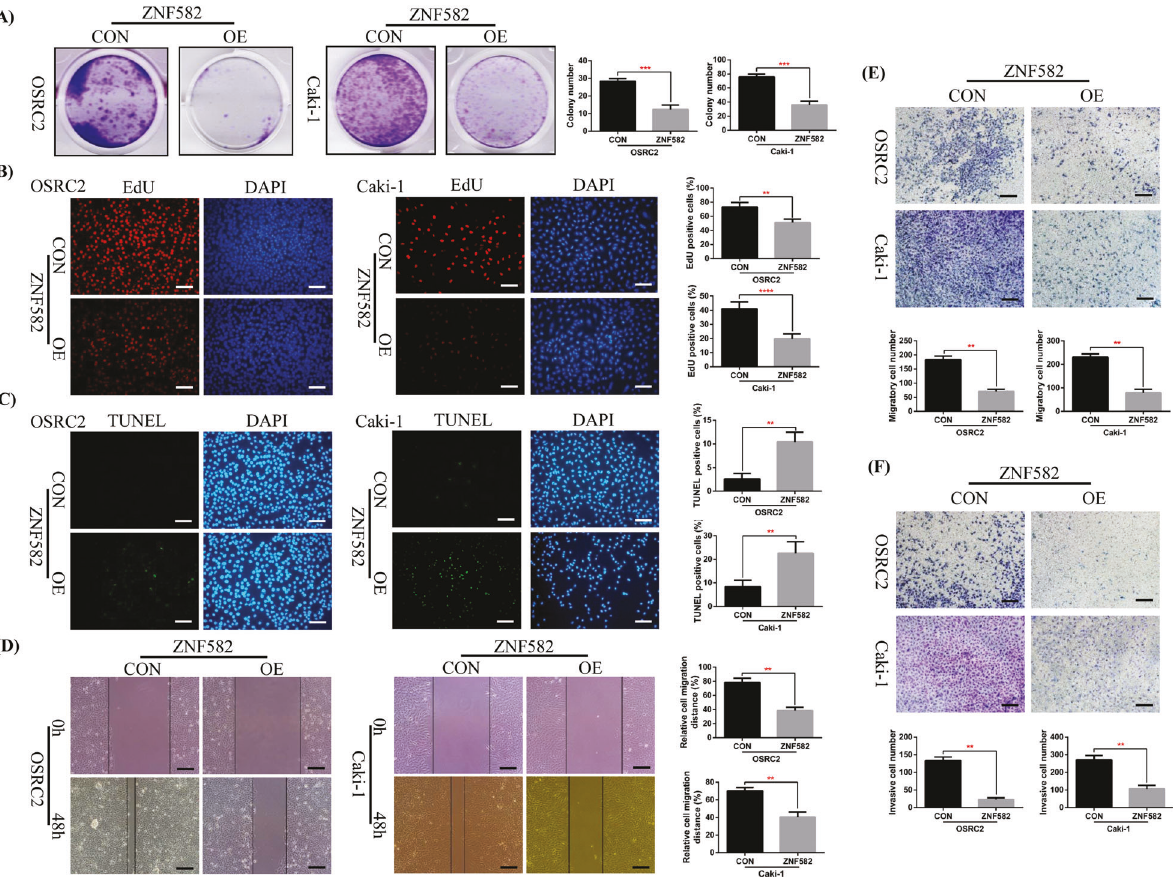
Fig. 2 ZNF582 overexpression inhibits the growth and migration of ccRCC cell in vitro. A Comparison of the number of cell clones in ZNF582 overexpression and control OSRC2 and Caki-1 cells. Comparison of the proportion of EdU ( B ) and TUNEL ( C ) positive cells in ZNF582 overexpression and control OSRC2 and Caki-1 cells by immuno fl uorescence (200X, Bar: 50 um). D Wound healing assay determined the migratory distances of ZNF582 overexpression and control OSRC2 and Caki-1 cells (100X, Bar: 100 um). Comparison of cell migration ( E ) and cell invasion ( F ) ability in ZNF582 overexpression and control OSRC2 and Caki-1 cells (100X, Bar: 100 um). The presentation of the histogram was the result of three independent experiments. ** P < 0.01, *** P < 0.001, **** P < 0.0001, compared with the corresponding Blot detection. Consistent with the hypothesis, in the same IP protein samples in OSRC2 and Caki-1 cells, TJP2 and ERK2 protein can only be detected in ZNF582 overexpression group (Fig. 3E, F). Western Blot results also identi fi ed that ZNF582 overexpression can lead to the increased expression of TJP2 and ERK2 proteins in OSRC2 and Caki-1 cells (Fig. 3G, H). ZNF582 overexpression up-regulates ERK2 expression by regulating TJP2 TJP2 (also known as ZO-2) is a cytoplasmic protein of tight junctions (TJs), which can combine with a variety of nuclear proteins, plays the role of a transcription inhibitor, and causes inhibition of cell proliferation and transformation [15]. So, can ZNF582 directly regulate ERK2 or affect ERK2 by regulating TJP2? In order to fully understand the regulatory relationship between ZNF582 and TJP2 and ERK2, we fi rst detected TJP2 and ERK2 protein expression in several ccRCC cell lines. Results showed that TJP2 expression is generally reduced in ccRCC cell lines and ERK2 expression is also decreased in OSRC2 and Caki-1 cells (Fig. 4A). Then, we constructed TJP2 stably transfected OSRC2 and Caki-1 cell lines. Anti-Flag M2 magnetic beads were also used to precipitate TJP2 protein, and anti-TJP2, anti-Flag, anti-ZNF582 and anti-ERK2 antibodies were also used for subsequent Western Blot detection. IP and Western Blot experiment results also indicated that TJP2 can bind to ZNF582 and ERK2 (Fig. 4B, C). Besides, ERK2 expression is also signi fi cantly increased after TJP2 overexpression in